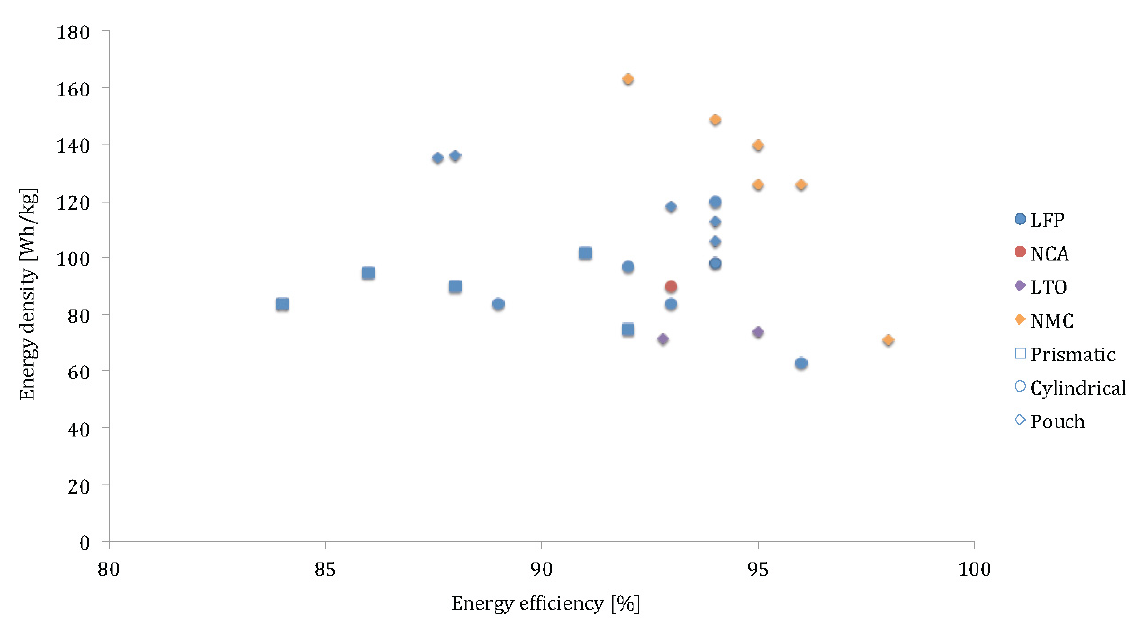
Figure 7. Energy density versus energy efficiency of various lithium-ion chemistries on cell